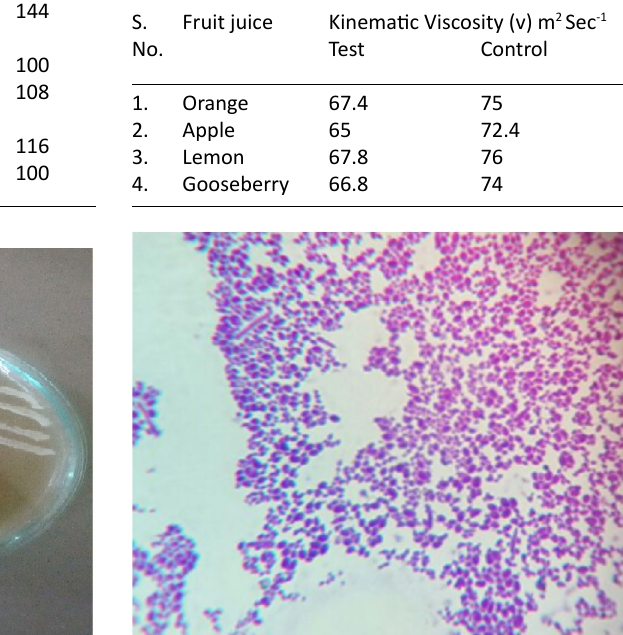
Table 4. Clarification of fruit juices by pectinase